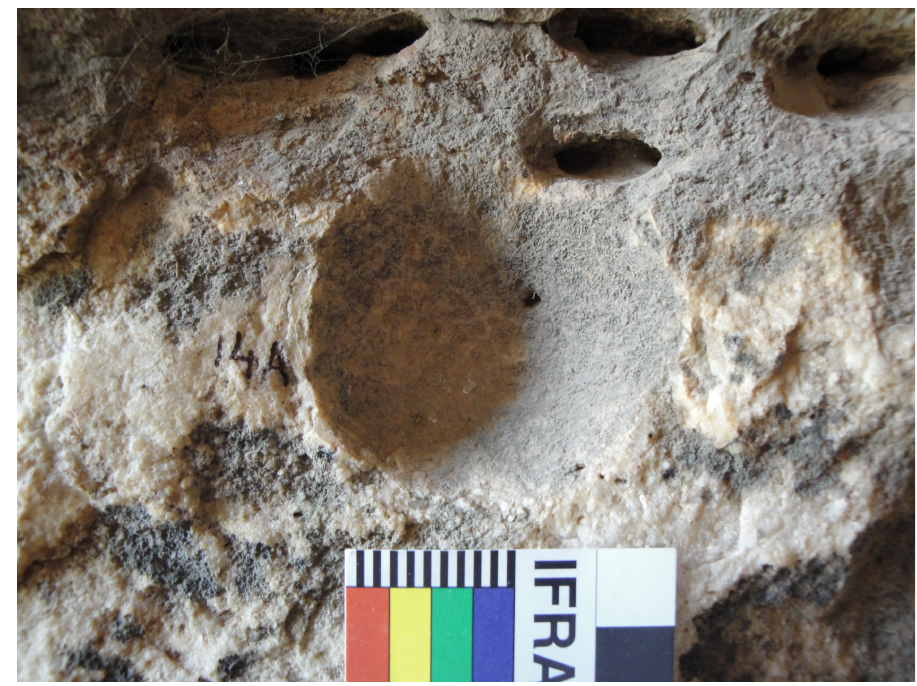
Figure 6. Big deep cupule in